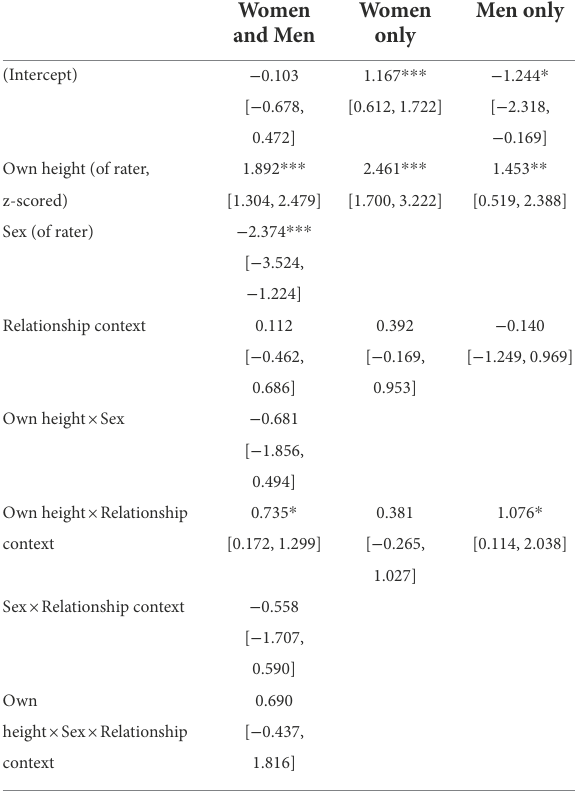
TABLE 3 Model 1: Linear mixed effects model testing for differences in assortative preferences for mate height as a function of a short- term versus long-term relationship context, nesting participants by